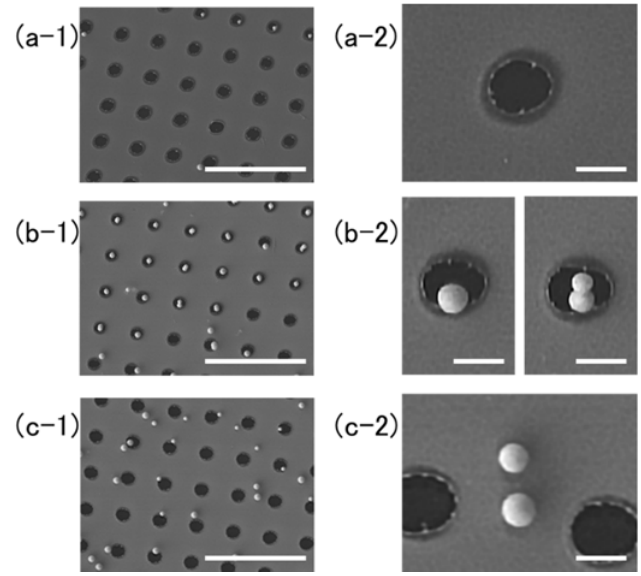
Figure 6. SEM images of the target surface. ( a ‐ 1 ) film thickness was 30 nm, and fluence was 58.6 mJ/cm 2 ; ( b ‐ 1 ) film thickness was 40 nm, and fluence was 58.6 mJ/cm 2 ; ( c ‐ 1 ) film thickness was 40 nm, and fluence was 169.9 mJ/cm 2 . Pictures on the right column are the corresponding magnified images: ( a ‐ 2 ) film thickness was 30 nm, and fluence was 58.6 mJ/cm 2 ; ( b ‐ 2 ) film thickness was 40 nm, and fluence was 58.6 mJ/cm 2 ; ( c ‐ 2 ) film thickness was 40 nm, and fluence was 169.9 mJ/cm 2 . The experimental parameters and results are summarized in Table 1. The white bars in the images on the left and right columns represent 5 μ m and 500 nm, respectively.